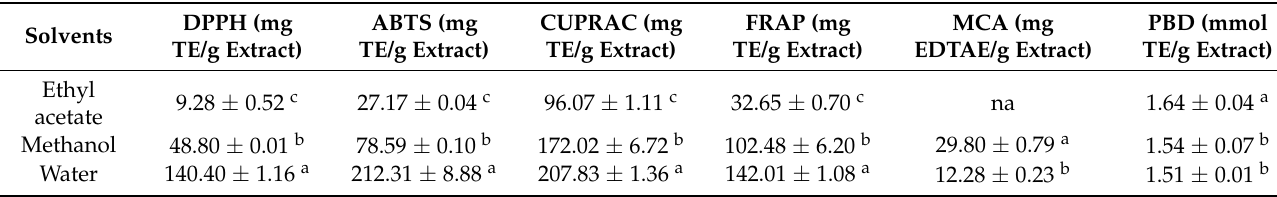
Table 3. Antioxidant properties of the tested extracts.